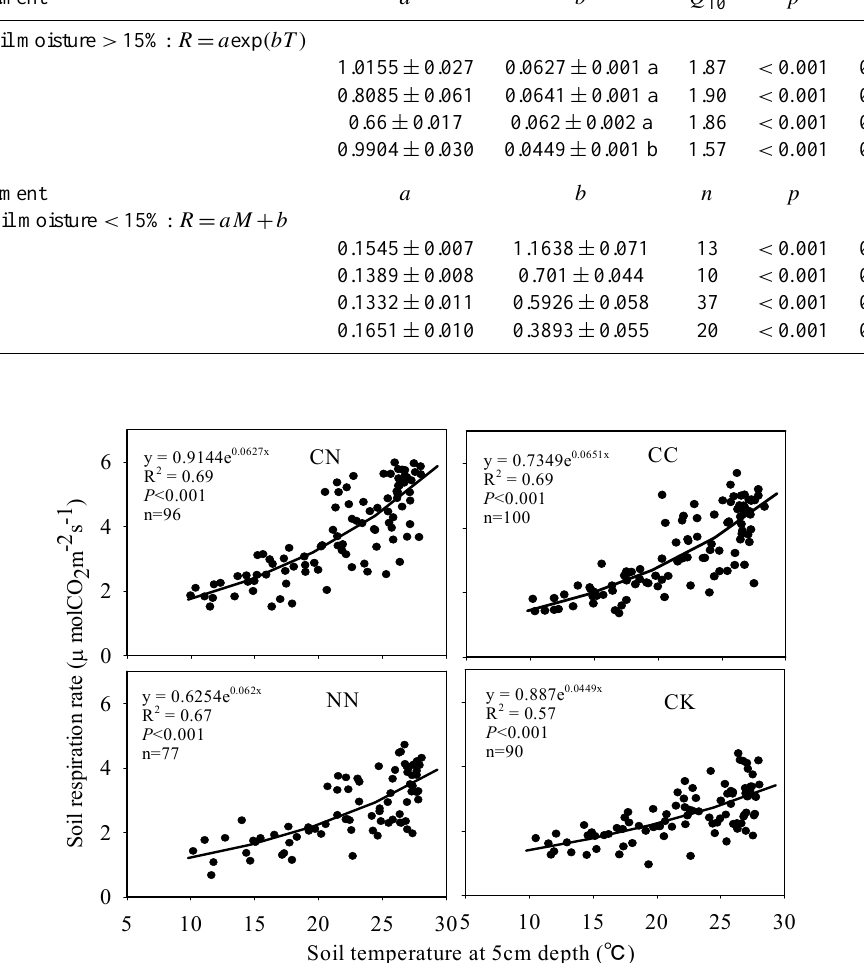
root biomass was 1.43, 1.29, 1.17 and 0.91 kg m − 2 in